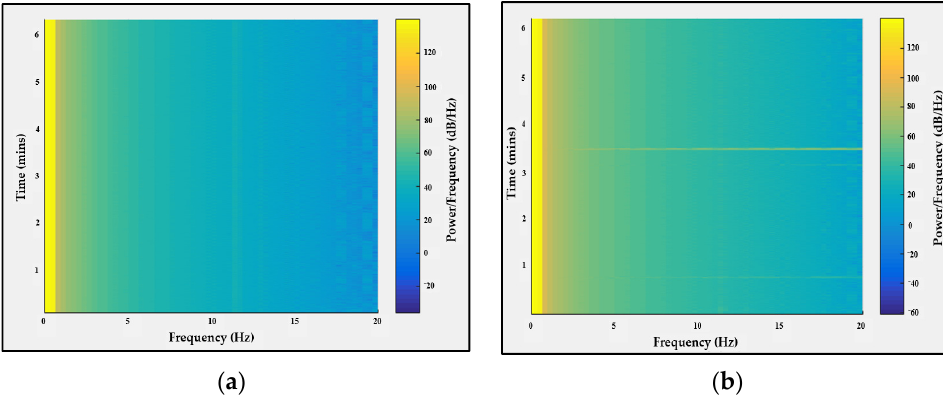
Figure 15. Alpha wave detection while (a) eyes were open and (b) eyes were closed.